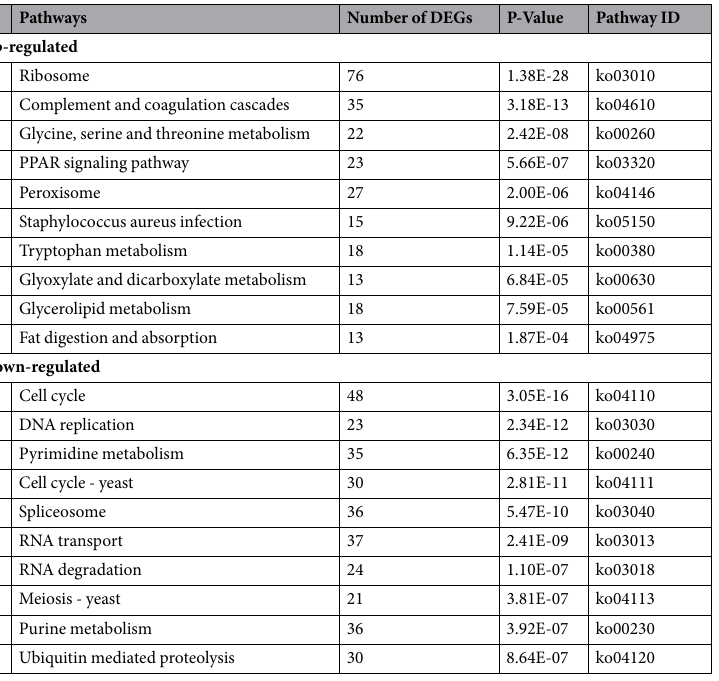
Table 2. Top 10 differentially up or down-regulated KEGG pathways in CMC-FeS treated zebrafish compared with the